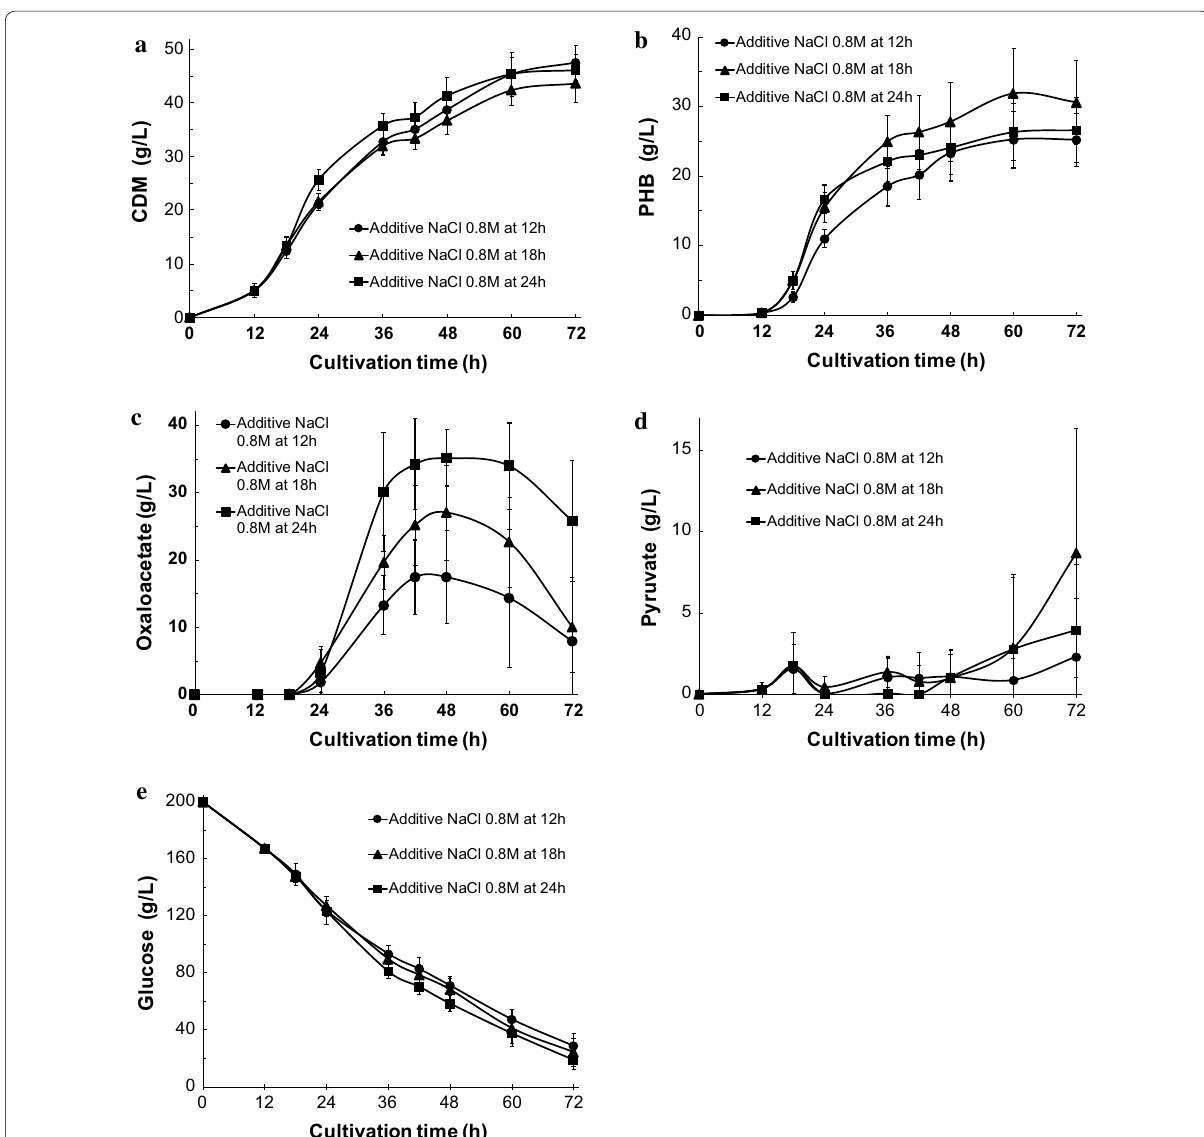
Fig. 2 Oxaloacetate, pyruvate, and bioplastic poly-( R )-3-hydroxybutyric acid production by strain KM-1 using different additive NaCl time-shifts. The medium was composed of modified SOT medium. KM-1 cells were cultured under aerobic conditions (agitation speed: 200 rpm) at 37 °C, with addi- tion of 0.8 M NaCl at 12 h (circles), 18 h (triangles), or 24 h (squares). a Cell dry mass (CDM), b intracellular bioplastic poly-( R )-3-hydroxybutyric acid (PHB), c oxaloacetate, d pyruvate in the medium, and e glucose in the medium were analyzed. The data shown represent the mean independent